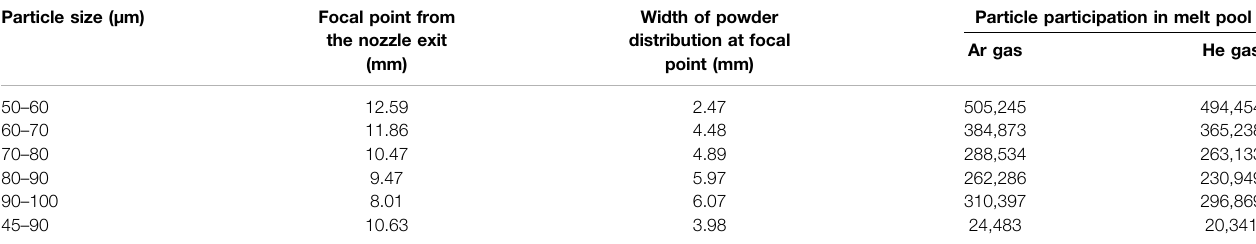
Particle participation in melt